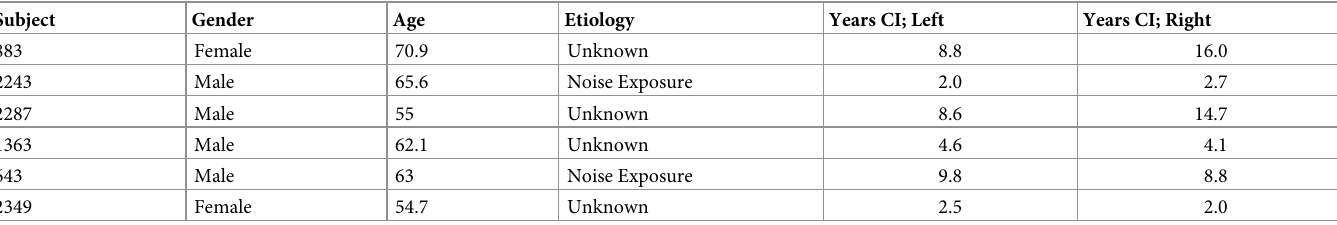
Table 1. There is one listener per row. Data include Gender, Age, the Etiology of the hearing loss, and the number of years of experience with the Left and Right